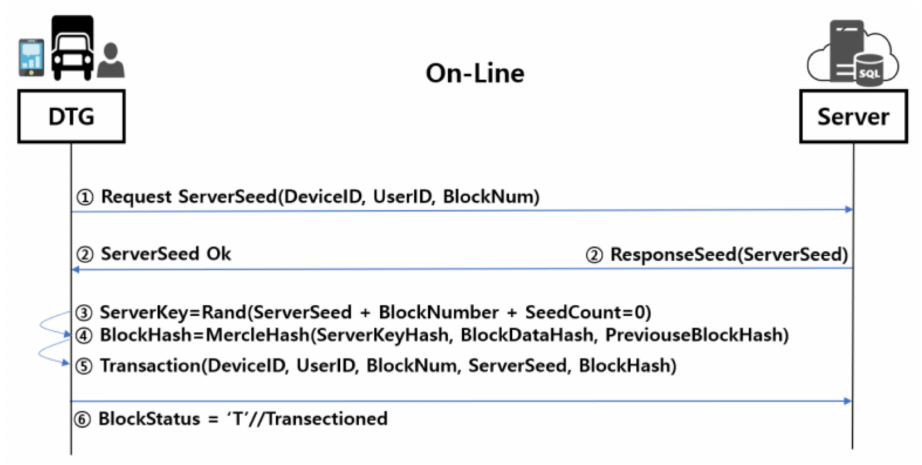
Figure 5. On-Line process of a block